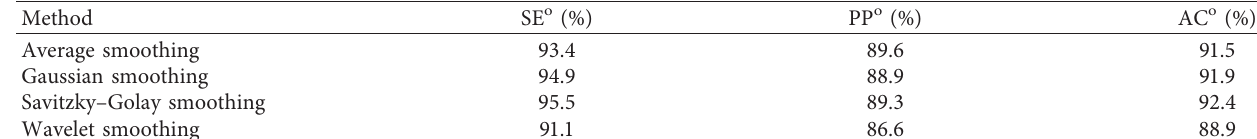
Table 5: Comparing to the smoothing methods with an oracle.